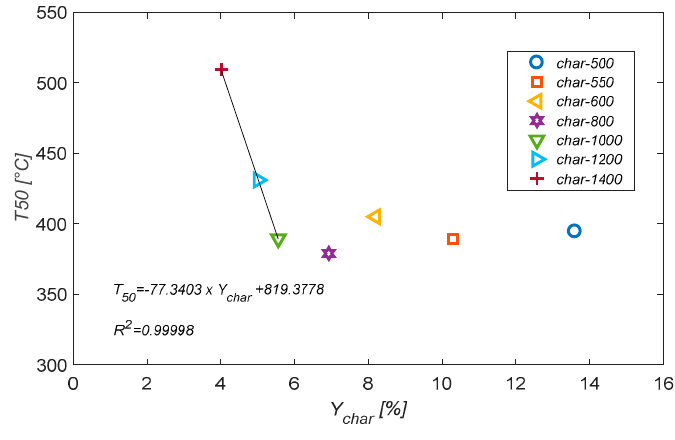
Figure 10. Evolution of T 50% with the char yield.